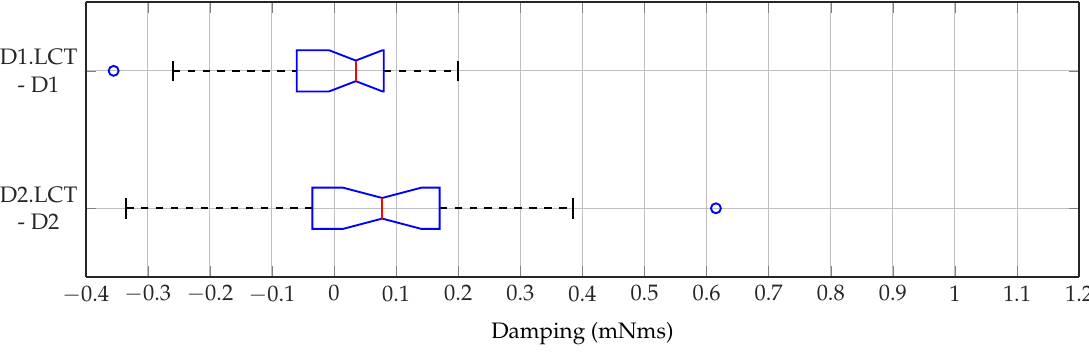
Figure 6. Effect of distraction on detection thresholds for damping with respect to knob diameter. Differences are not significant.